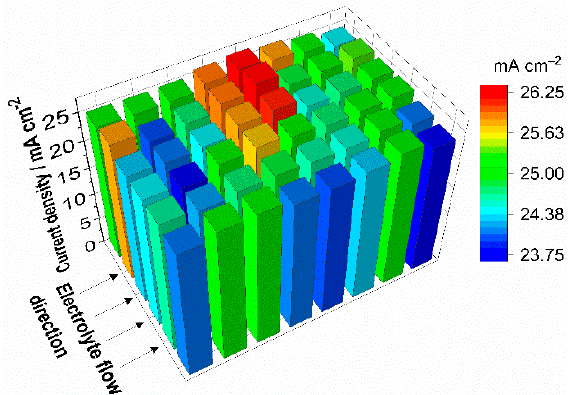
Figure 1. Current density distribution during discharge with 25 mA cm − 2 and 2.5 mL min − 1 cm − 2 ( λ > 100) for both electrolytes, starting at SOC 50%. The segmented current collector was installed at the cathode of the battery.